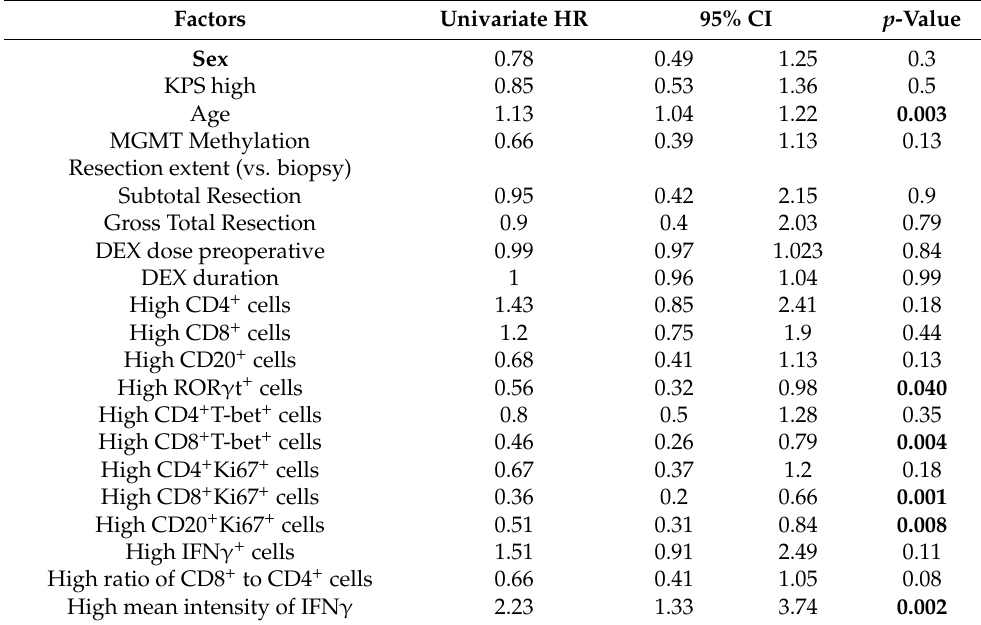
Table 2. Univariate analysis of evaluated clinical and immunological factors and overall survival.